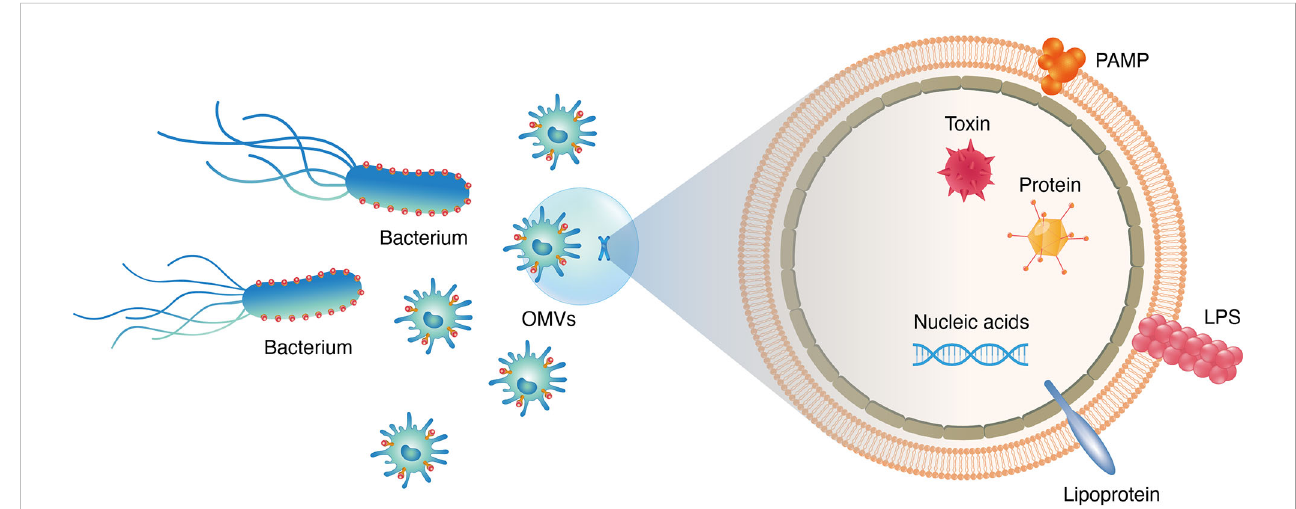
FIGURE 2 Different functional constituents existed in bacteria derived OMVs, e.g., proteins, nucleic acids, lipids, virulence factors and